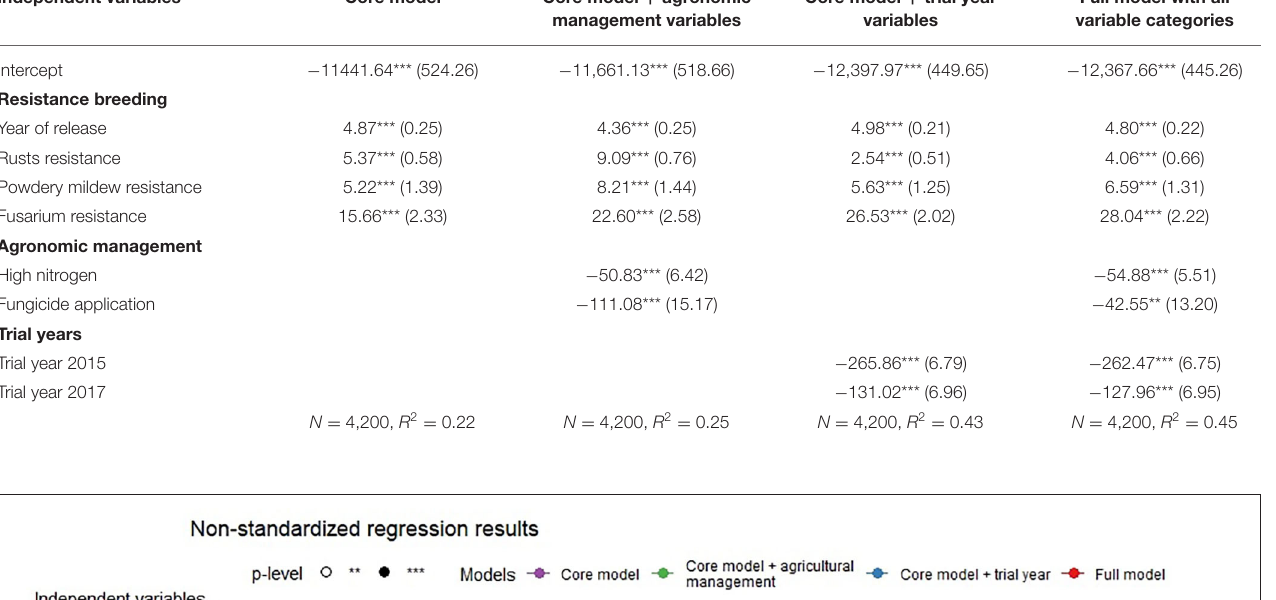
TABLE 3 | Coefficients (standard errors) of the non-standardized regression models with gross margin as the dependent variable (significance codes: *** p < 0.001, ** p < 0.01). Independent variables